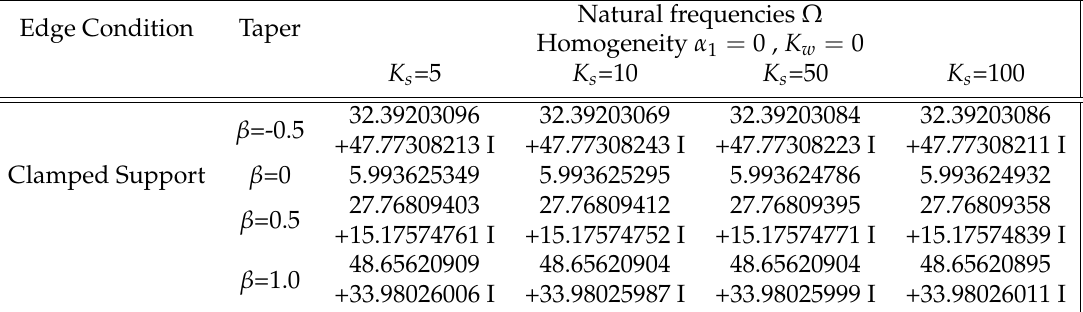
Table 9. Influence of taper on natural frequency of combine foundations parameter